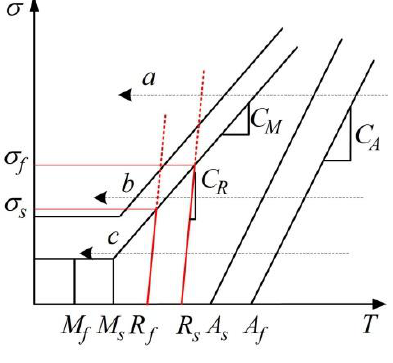
Figure 8. Revised critical stress-transformation temperature